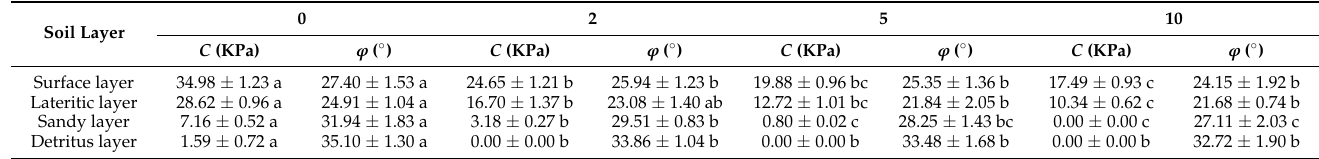
Table 4. Shear strength of experimental soils under W-D